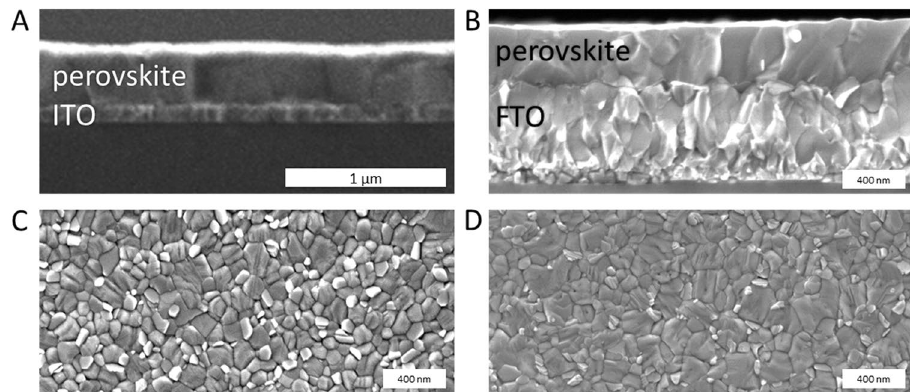
R q R a Contact angle ITO 2.154 nm 1.765 nm 67.8° ± 1.24° Polished FTO 14.963 nm 11.275 nm 58.0° ± 1.19° 45.425 nm 35.916 nm 52.0° ± 1.9° Table 1. Surface roughness and contact angle of perovskite solution on ITO, polished FTO, and FTO. The root mean squared of the vertical deviations of the roughness profile from the mean line is R q and the arithmetic average of the vertical deviations is R a . The values have been quantified through atomic force microscopy (AFM) measurements.